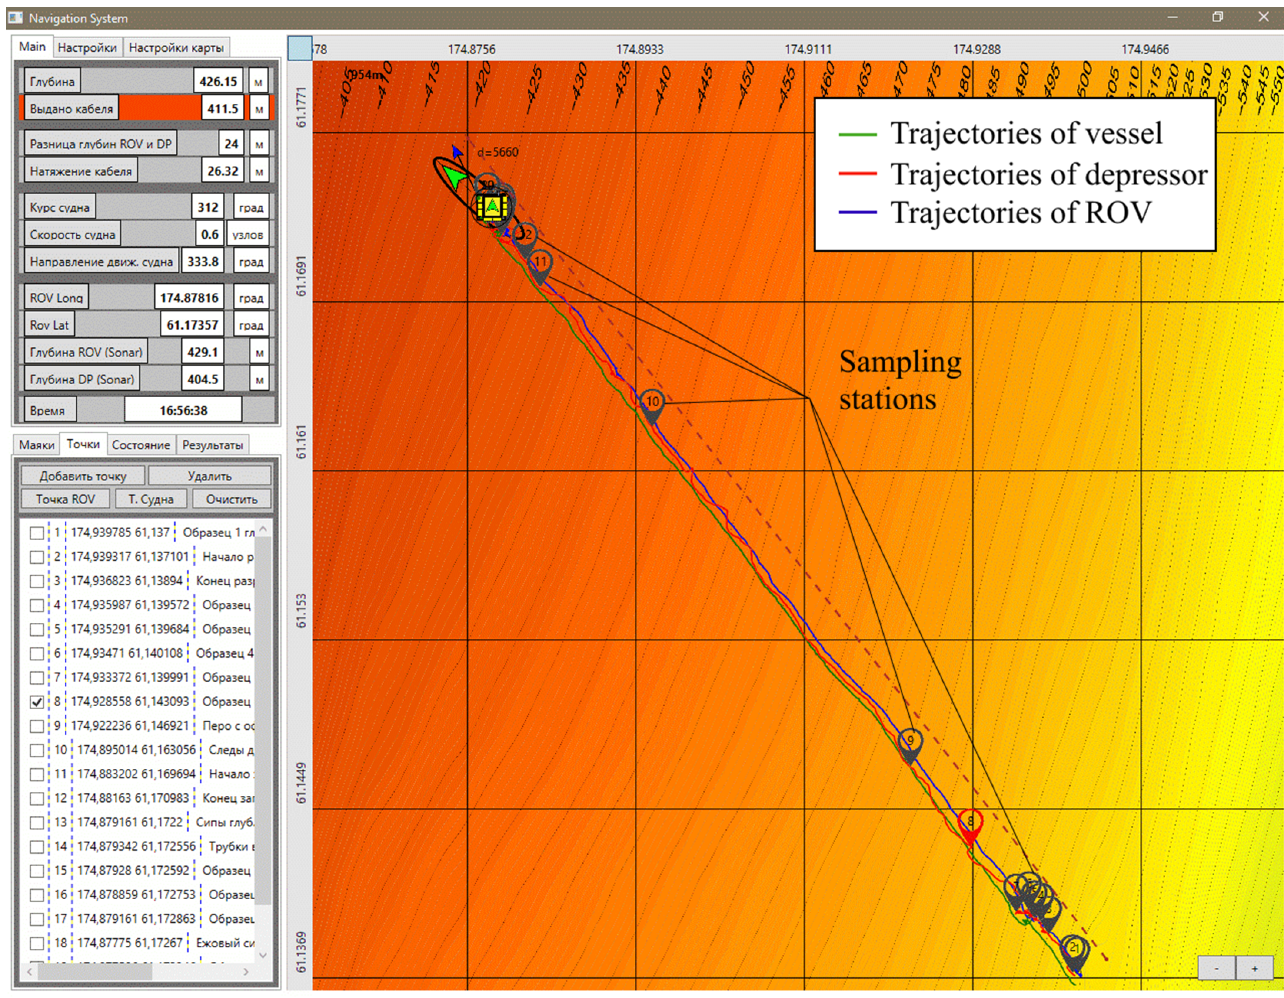
Figure 10. Movement of ROV along the shelf slope of Chukotka.